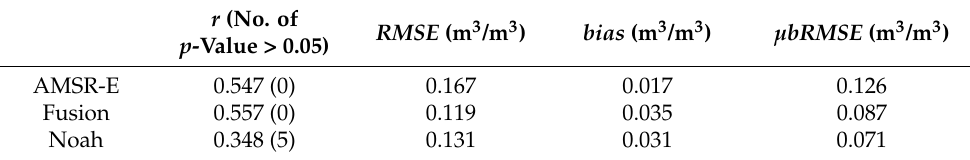
Table 4. Average of temporal variation evaluations against in situ data at MODIS scale. r (No. of RMSE (m 3 /m 3 ) bias (m 3 /m 3 ) µ bRMSE (m 3 /m 3 ) p -Value > 0.05) AMSR-E 0.547 (0) 0.167 0.017 Fusion 0.557 (0) 0.119 0.035 0.087 Noah 0.348 (5) 0.131 0.031